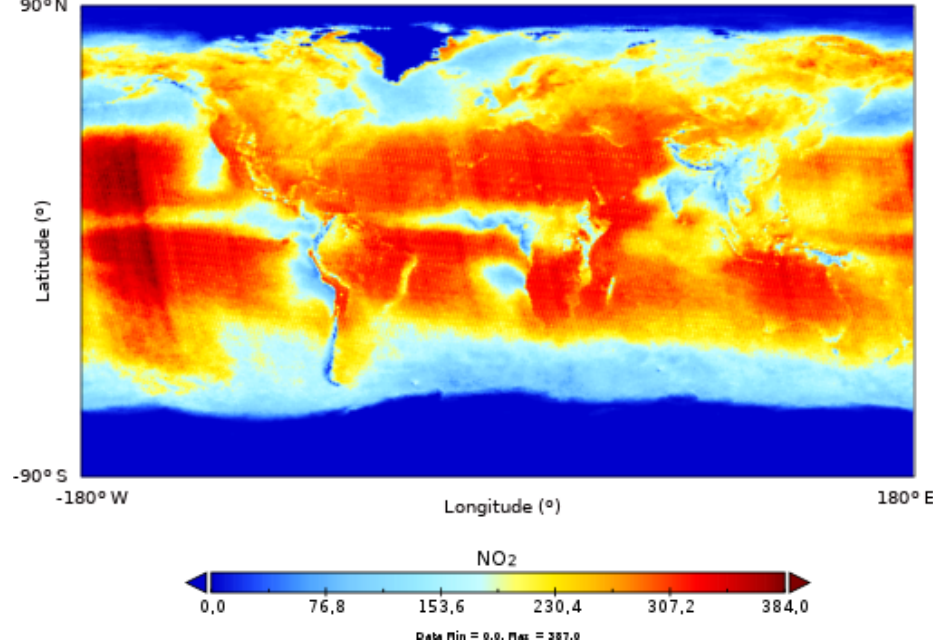
Figure 4. Climatology of NO 2 (Dobson units × 10 3 ) for the month of August. Data obtained from OMI version 3 (OMNO2d gridded, level 3) data between 2005 and